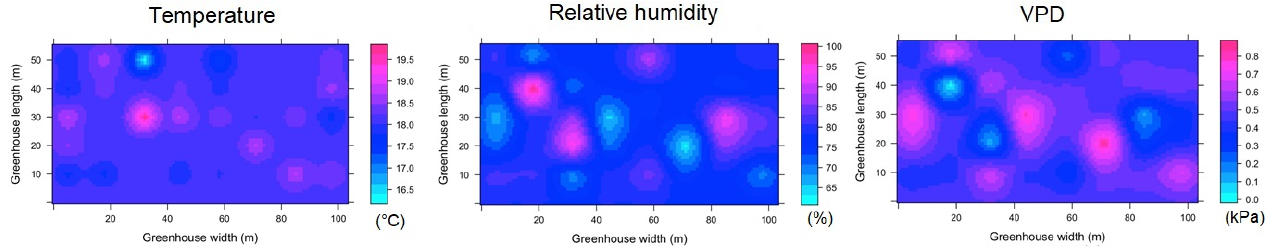
Figure A2. Spatial distribution predicted by kriging, for temperature, relative humidity and VPD in MG and for ESRL 3.